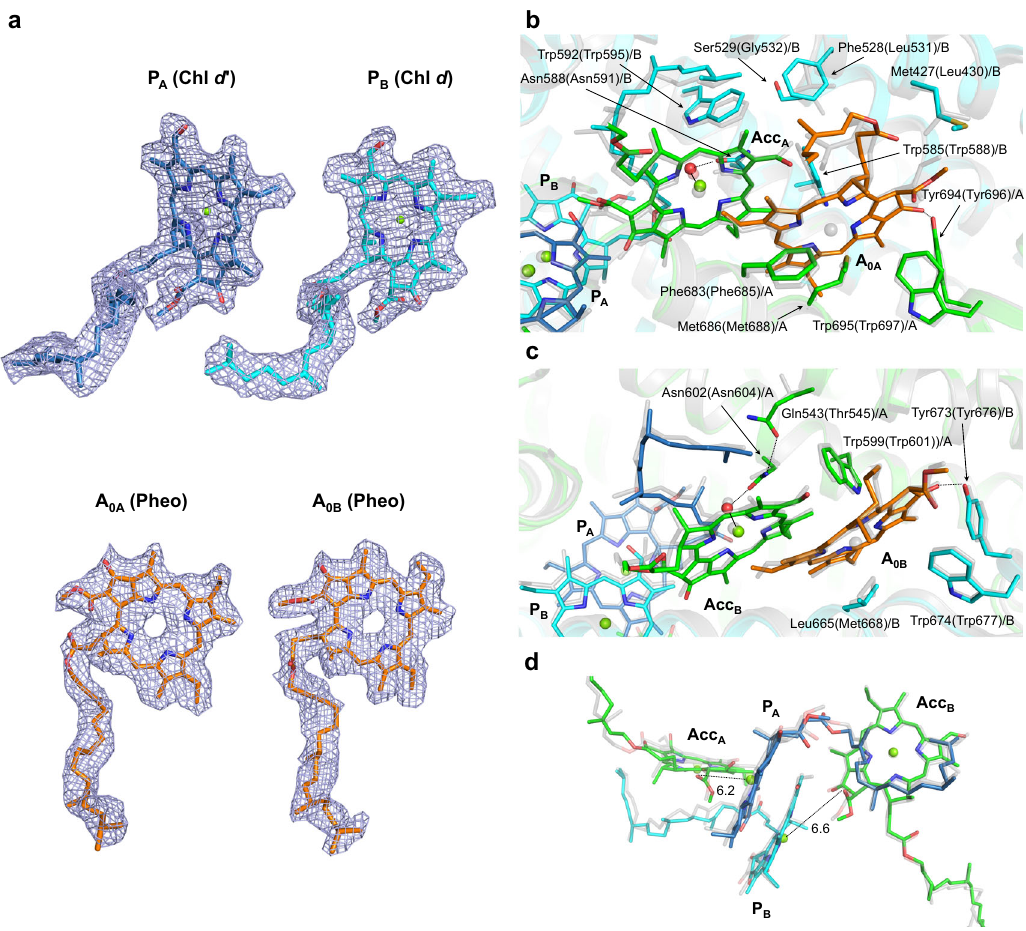
Fig. 5 Arrangement of A 0 , Acc, and the surrounding protein environment. The structural model of PSI from A. marina is superposed with that from T. elongatus (PDB code 1JB0). a Cryo-EM density map of P A , P B , A 0A , and A 0B . Each map is shown in a mesh representation at 1.0 sigma contour level. b Arrangement of A 0 , Acc, and the surrounding protein environment. c As in b , but view from the pseudo-C 2 axis. d Geometry of P A /P B and Acc (Acc A and Acc B ). Chl d , green; Pheo, orange; water molecule, red. Colors are the same as in Fig.